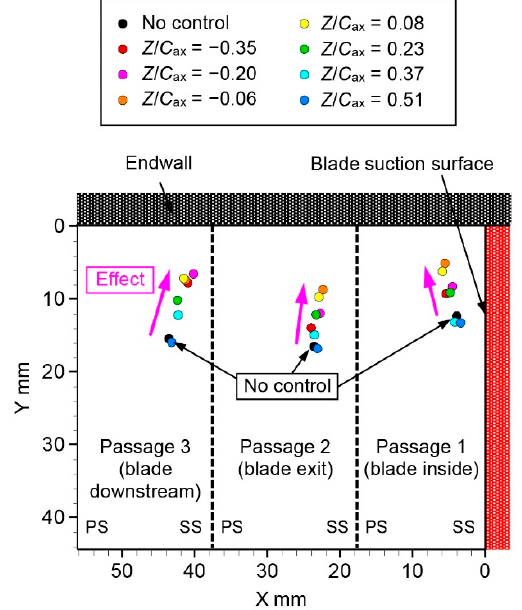
Figure 20. Center positions of passage vortex at various plasma actuator locations (Re out = 3.7 × 10 4 ).